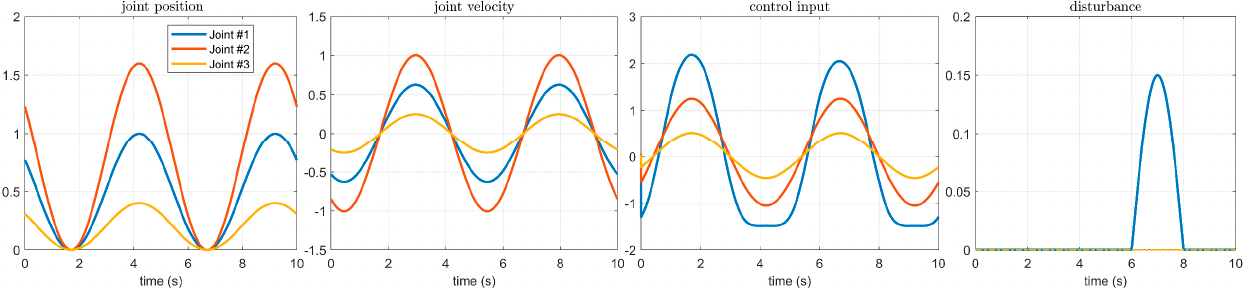
Figure 2. Manipulator motion trajectory, controller input, and disturbance.